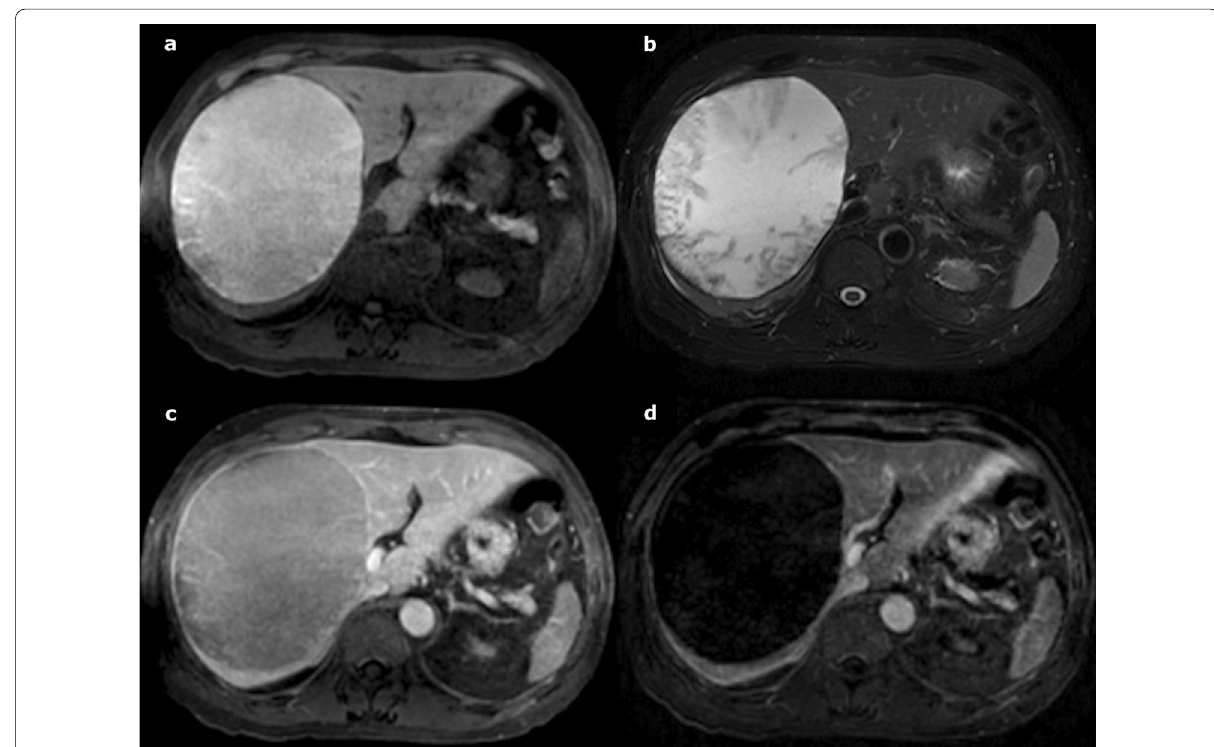
Fig. 7 Haemorrhagic cyst in a 55-year-old male patient. a Axial T1 fat-sat-weighted magnetic resonance imaging shows hyperintense lesion and ( b ) axial T2-weighted magnetic resonance imaging shows a heterogeneous hyperintensity; c and d axial T1-fat-sat-weighted imaging without and with subtraction shows no enhancement after gadolinium-chelate injection